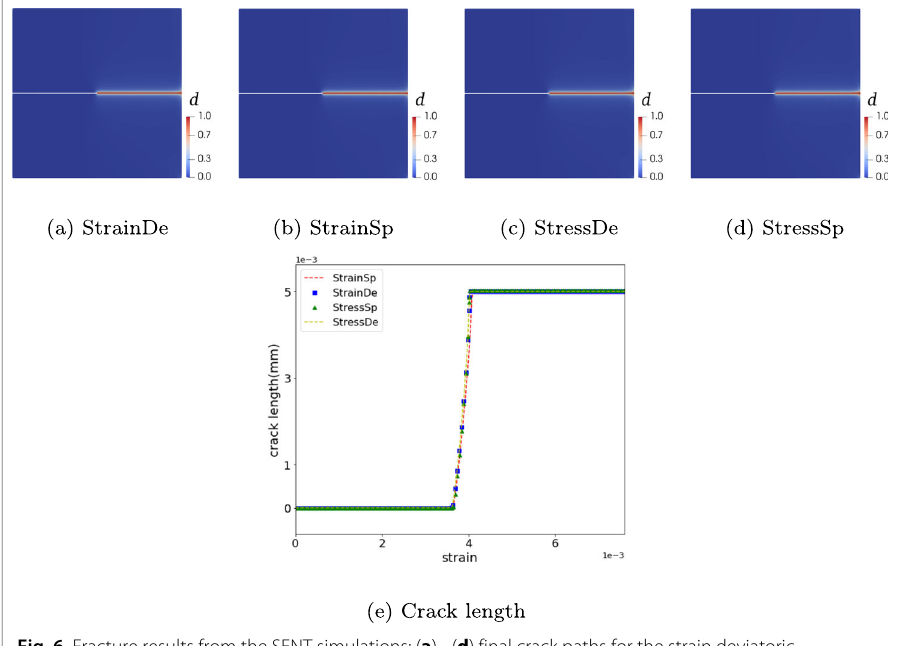
Fig. 6 Fracture results from the SENT simulations: ( a ) - ( d ) final crack paths for the strain deviatoric decomposition, strain spectral, stress deviatoric decomposition, and stress spectral methods, respectively. The initial cracks are shown in white. ( e ) the crack length evolution for the four